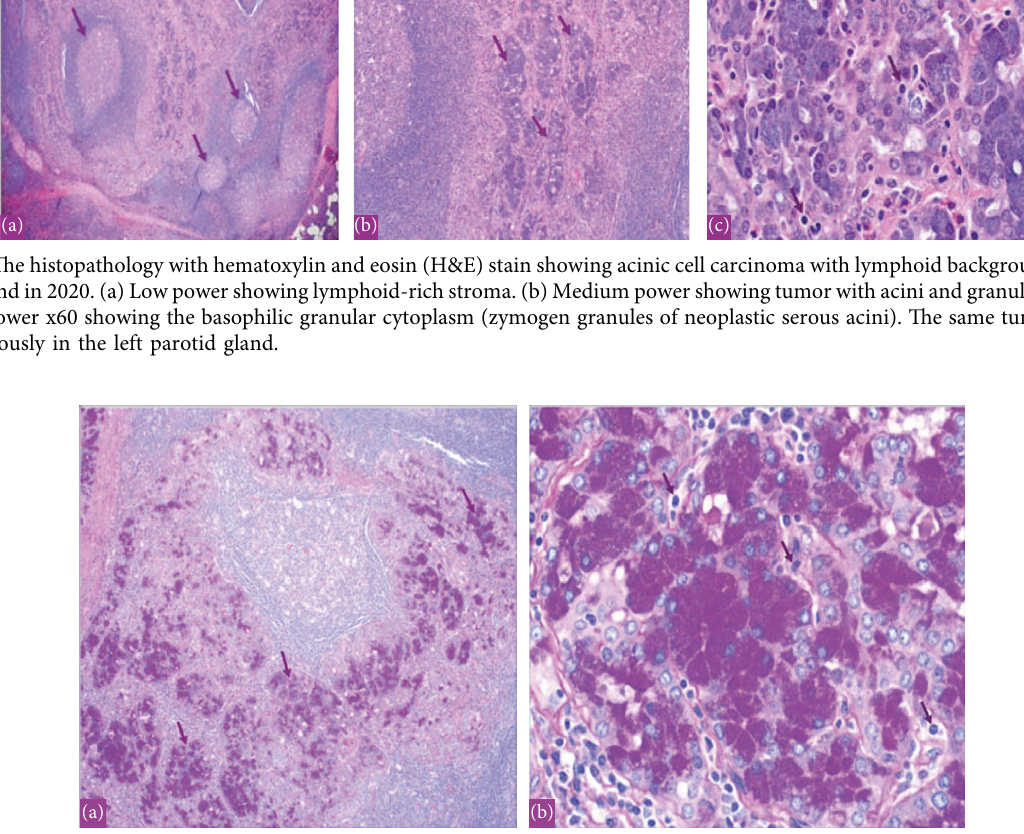
Figure 8: The histopathology with periodic acid–Schiff plus diastase (PASD) stain showing acinic cell carcinoma of the left parotid gland in 2020. (a) Periodic acid–Schiff plus diastase (PASD) stain low power showing acinic cell carcinoma cells with PASD-positive granular cytoplasm. (b) Periodic acid–Schiff plus diastase (PASD) stain high power showing PAS+diastase resistant granules in Acinic cells.